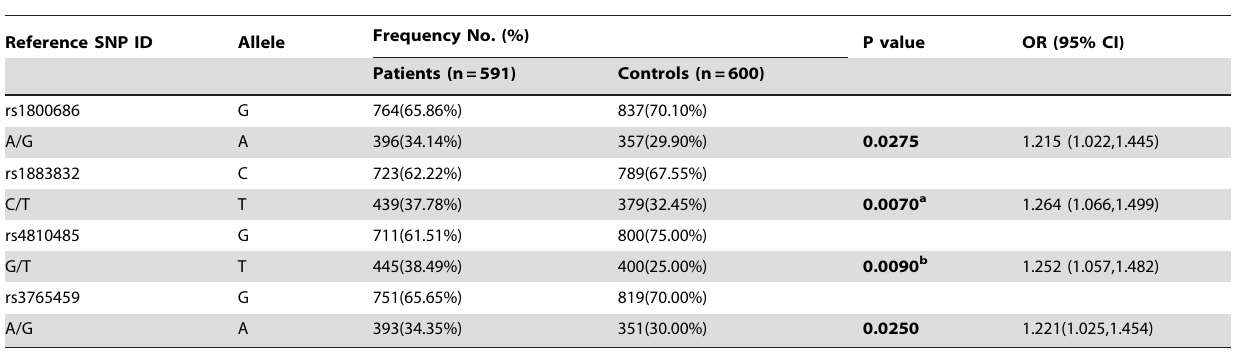
Table 2. Alleles of the four SNPs in CD40 gene.